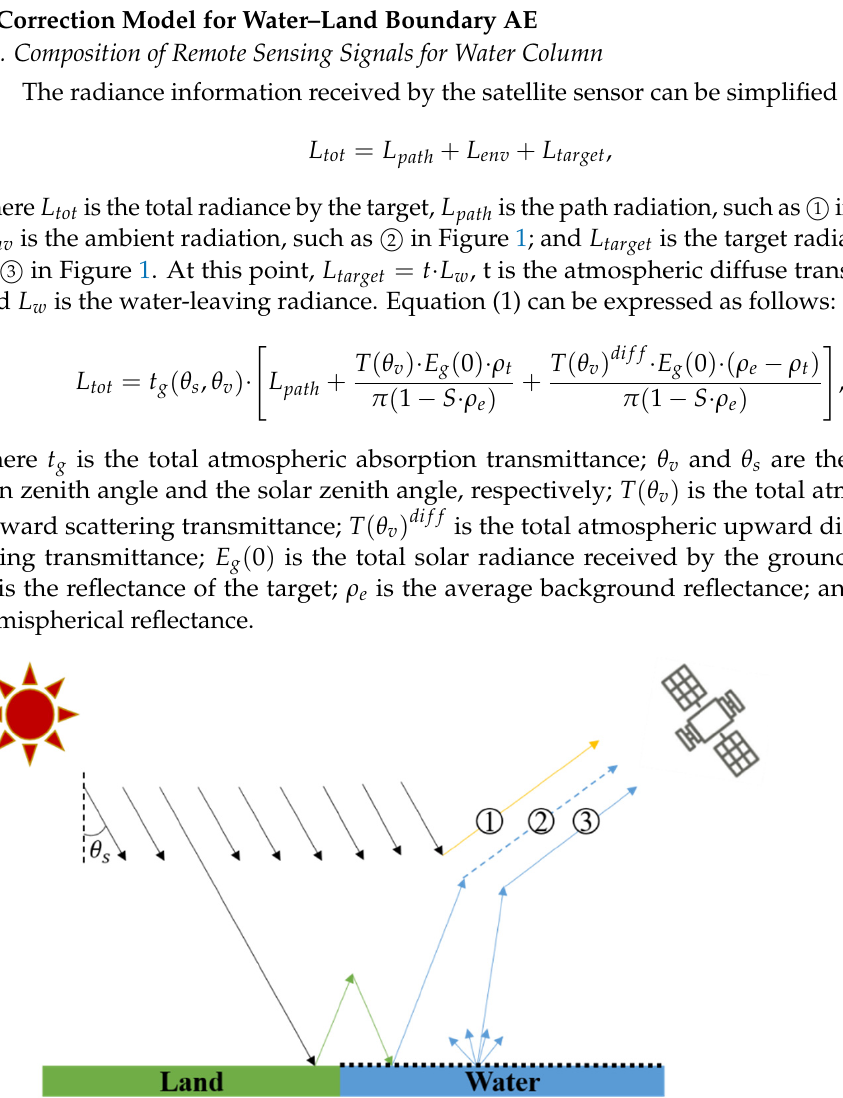
Figure 1. Composition of the remote sensing signal of a water column. 1 (cid:13) is the part that returns directly to the sensor through atmospheric action, that is, the atmospheric path radiation. 2 (cid:13) is the portion of solar radiation reflected from surrounding features and entering the sensor by atmospheric action, that is, the solar radiation generated by the AE. 3 (cid:13) is the solar radiation entering the sensor reflected by the